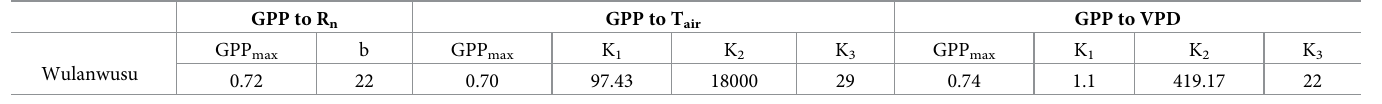
Some researchers have contended that at the daily scale, GPP could be reliably predicted from R and T [32]. Therefore, the study simulates GPP driven separately by R and T on a n air n air daily scale. RH and VPD are strongly correlated with the GPP-R relationship (R 2 = 0.40 and n 0.17, respectively) (Table 2) and the GPP-T relationship (R 2 = 0.46 and 0.39, respectively) air (Table 3). RH is the most important variable explaining the variability of the residuals and VPD is second (Tables 2 and 3). However, SWC and Ustar have slight impacts on the GPP residuals (Tables 2 and 3). RH, Ustar, and VPD are stronger correlations to the residuals of the